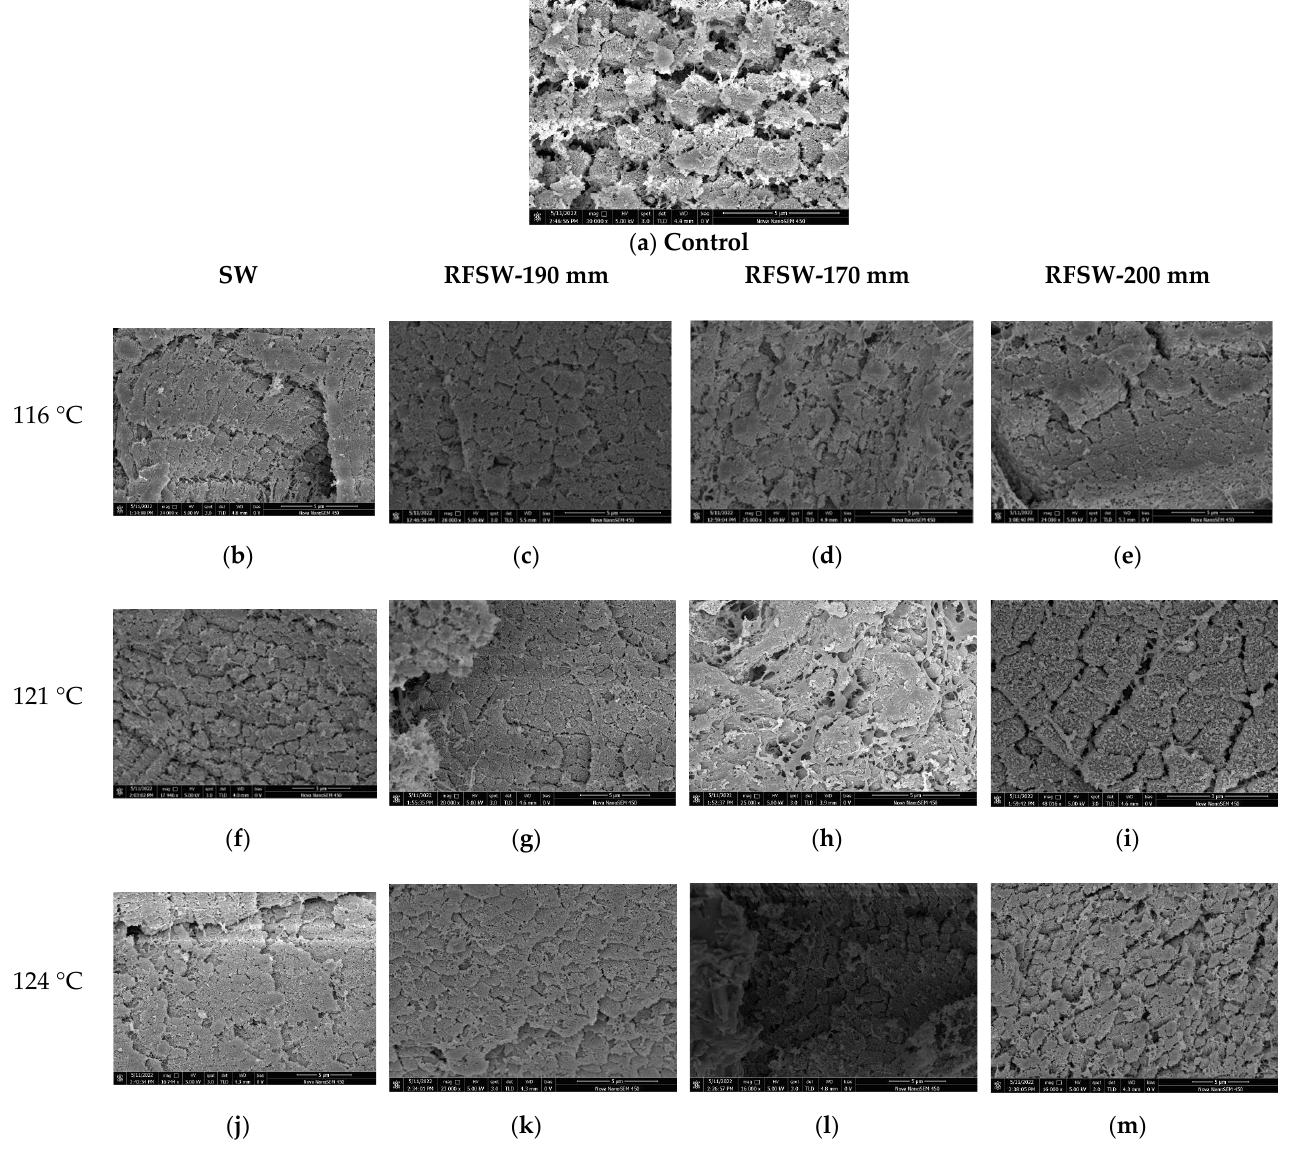
Figure 9. SEM micrographs of myofibrils in pork slices after sterilization with different electrode gaps and superheated-water temperature (control group means starching pork slice without sterilization).